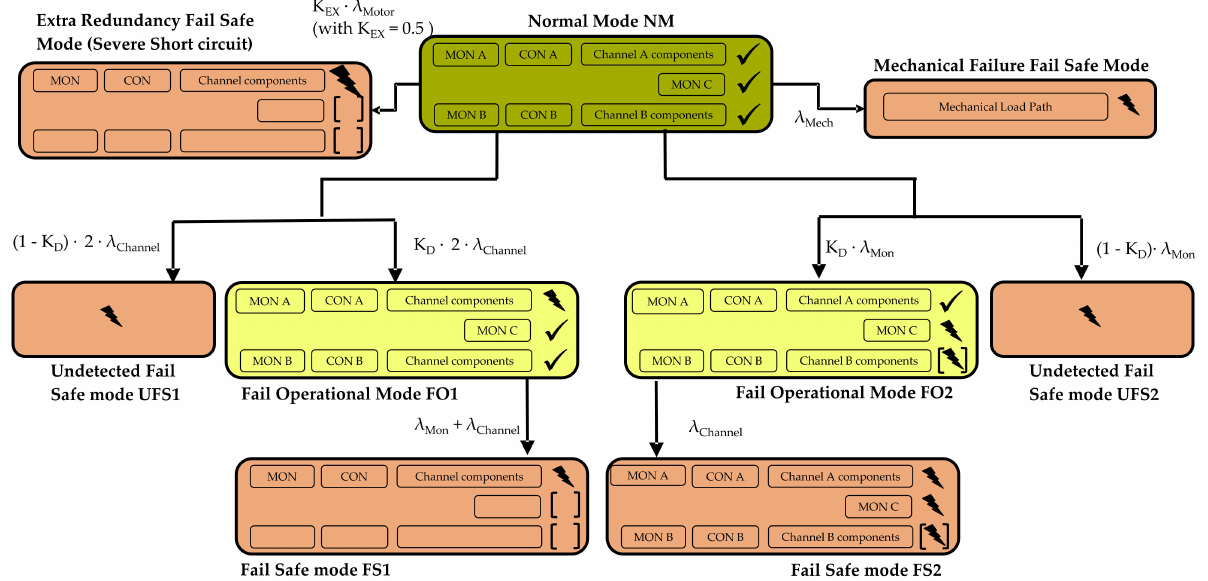
Figure 2. Stochastic Markov Model with 9 different operating states and 3 operating modes (NM: green, FO: yellow, FS: